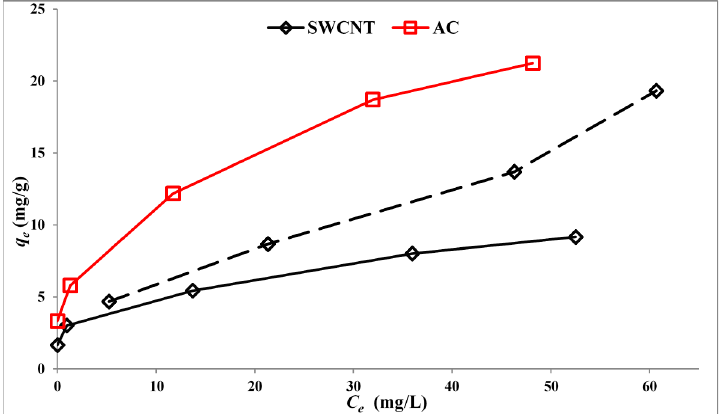
Figure 6. Adsorption isotherms at 22 °C for SMX on activated carbon (AC) or single-walled carbon nanotubes (SWCNT). SWCNT: solid line, 5.0% by weight; dashed line, 0.25% by